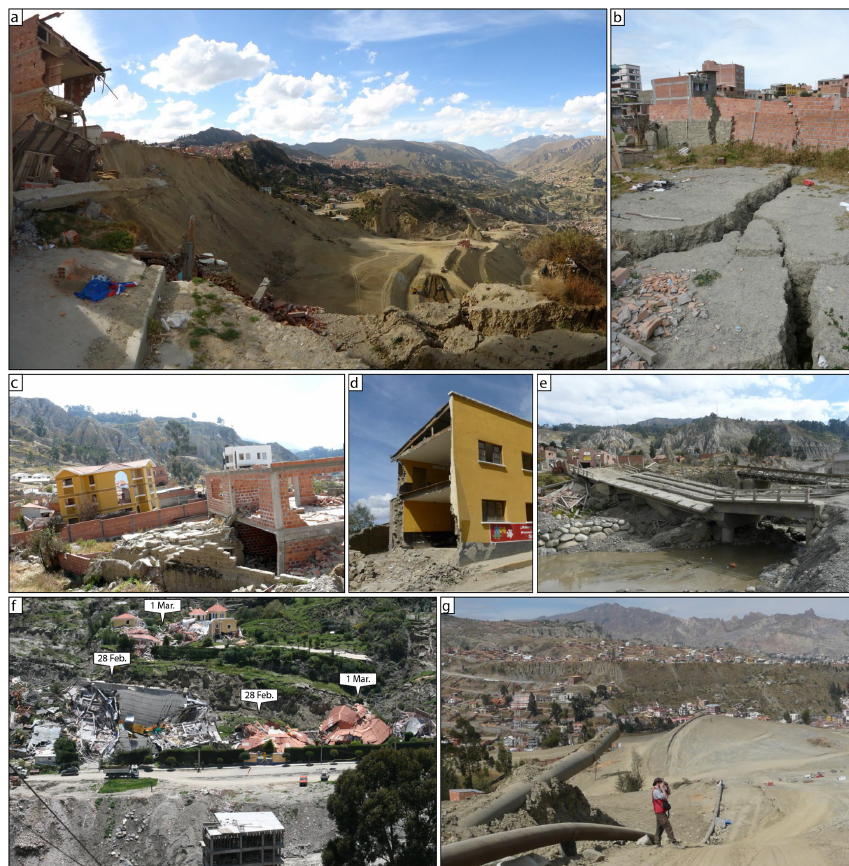
Figure 6. Impacts of the 2011 Pampahasi landslide. (a) Head scarp (80m height) along the east margin of Pampahasi Plateau (note excavator and trucks in lower middle ground for scale). (b) Ground fissures in the northern part of the lower landslide mass. The wall in the background is ∼ 2m high. (c) Back-tilted houses and apartment buildings on the northern part of the lower landslide mass (movement was from left to right). (d) Community building with collapsed wall on the northern part of the lower landslide mass. (e) Bridge across Río Irpavi that was deformed and shifted from its footings on 27 February near the centre of the landslide toe. (f) Buildings on the southern part of the toe of the landslide that collapsed on 28 February and 1 March (dates of collapse shown; photo by Marco-Antonio Guzmán, 2 March 2011). (g) Water service line ruptured by the landslide (upper pipe) and replacement water service line (lower pipe). See Figs. 2b and 8c, d for locations of photographs. Photos taken by Nicholas J. Roberts in May 2011 unless otherwise